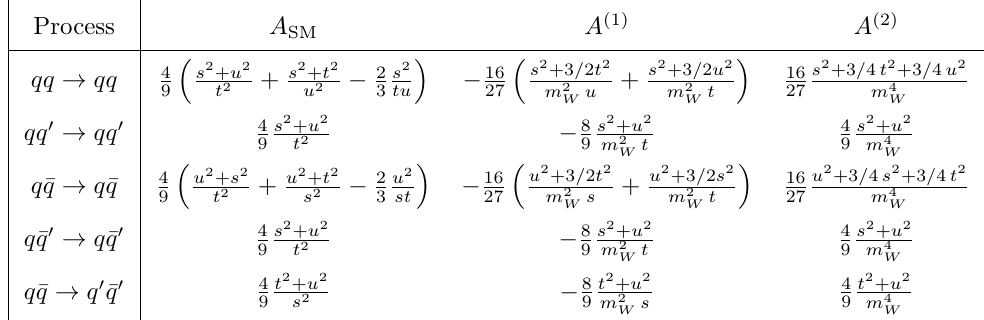
Contribution of eq. (1.5) to 2 ! 2 quark amplitudes. We write jMj 2 = g 4 A (1) Z + A (2) Z 2 ), where jMj 2 is the matrix element square summed over (cid:12)nal state and